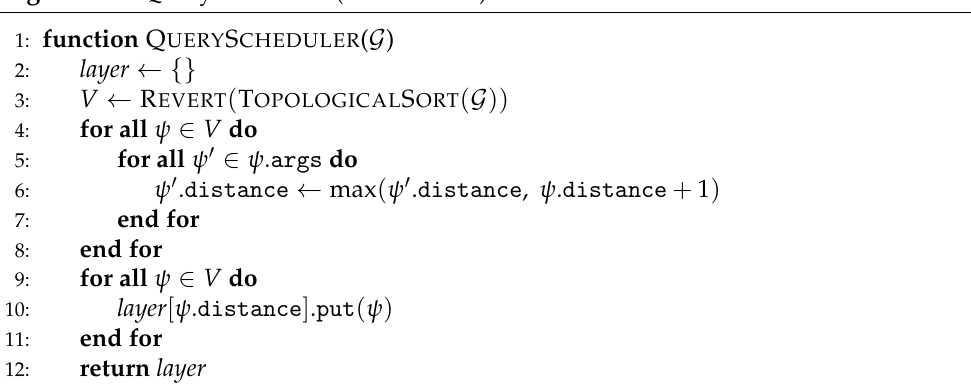
Algorithm 5 Query Scheduler (Section